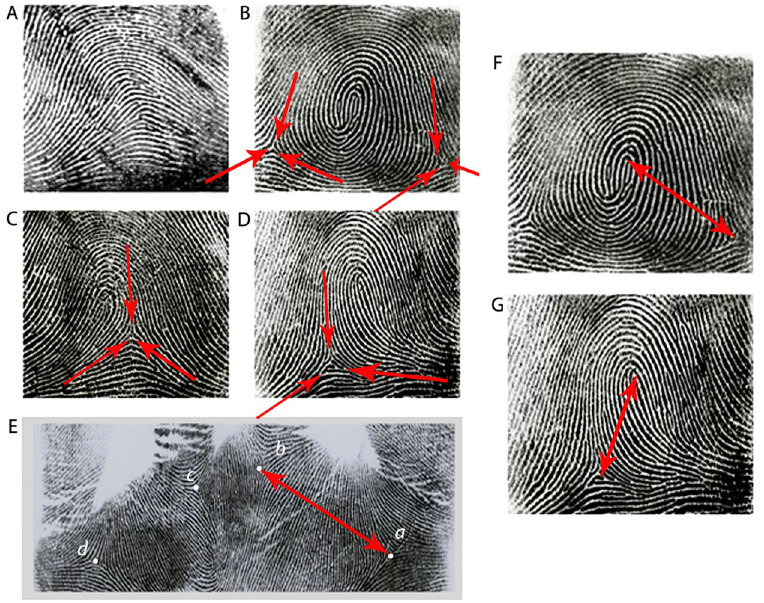
Fig 1. Fingerprint pattern types: A. Arch, B. Whorl, C. Radial loop, D. Ulnar loop, E. A-B ridge count, F. Finger ridge count in whorl pattern, G. Finger ridge count in loop